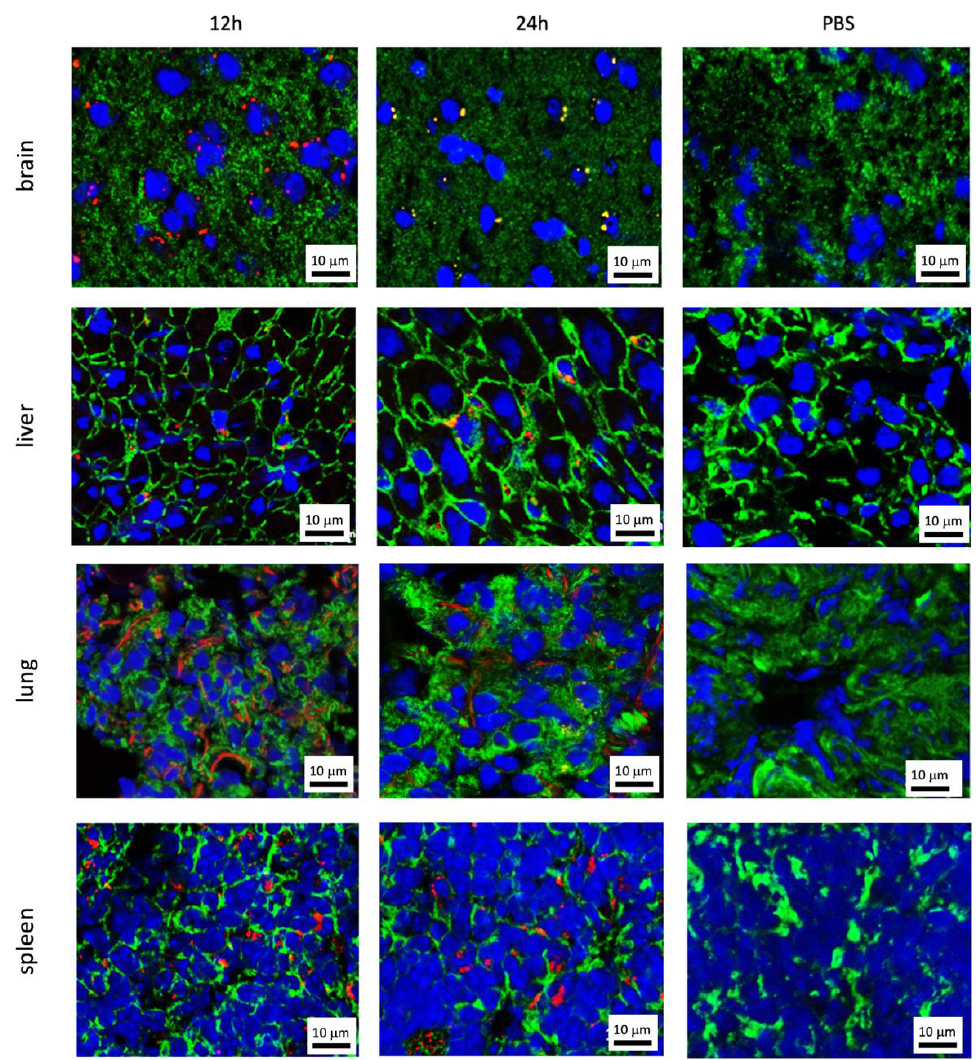
Figure 3. EV-positive organs after intravenous injection of fluorescence labeled EVs. Representative images of the brain, liver, lung, and spleen (rows 1–4) 12 and 24 h after intravenous EV injection (columns 1 and 2, respectively) or after PBS injection (control; column 3) are shown. Here, slides from animals who had 786-O EVs injected are shown as an example. The cytoskeleton of the cells is marked in green (Phalloidin-Alexa488) and their nuclei are marked in blue (DAPI). EVs appear in red (PKH26). Note that in the image of the brain at 24 h, EVs show as yellow dots, which is probably caused by an intense green signal from Alexa488 at the same location as the red EV signals resulting in a superposed yellow signal. This was probably due to a methodological issue in this individual experiment. Resolution 1000-fold; scale bar = 10 μm.